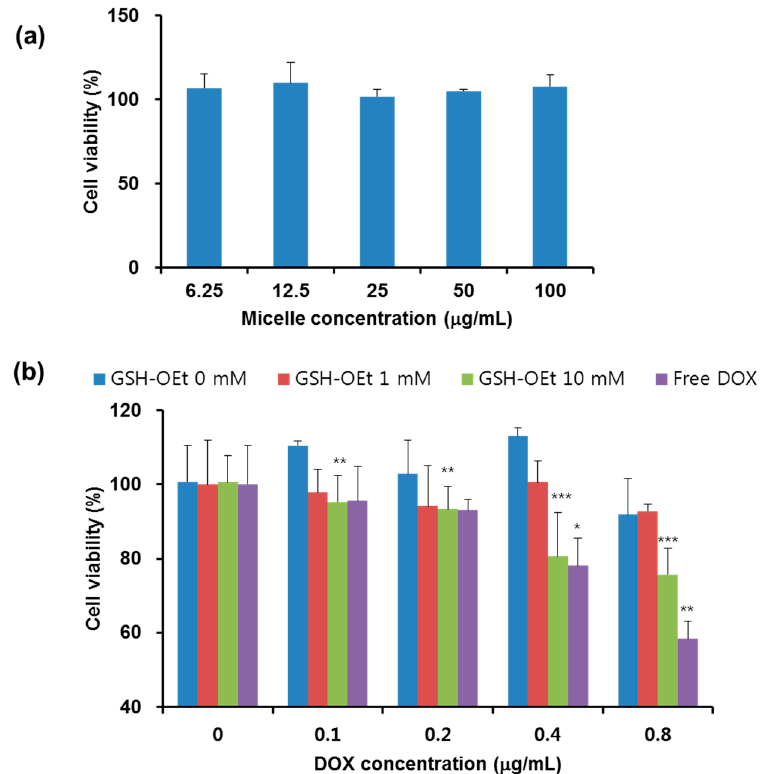
Figure 8. ( a ) KB cell viability after incubation with different concentrations of poly(ethylene glycol)-cholesteryl conjugate (Chol-ss-PEG-ss-Chol) micelles for 24 h; and ( b ) KB cell viability after pretreatment with and without glutathione reduced ethyl ester (GSH-OEt), followed by incubation with different concentrations of free doxorubicin (DOX) and DOX-loaded Chol-ss-PEG-ss-Chol micelles for 24 h. Results are mean ± standard deviation (SD), n = 3 (* p < 0.05, ** p < 0.01, and *** p < 0.001).